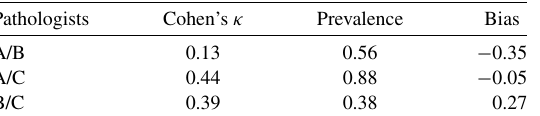
Statistics of pathologist agreement of mitotic figures